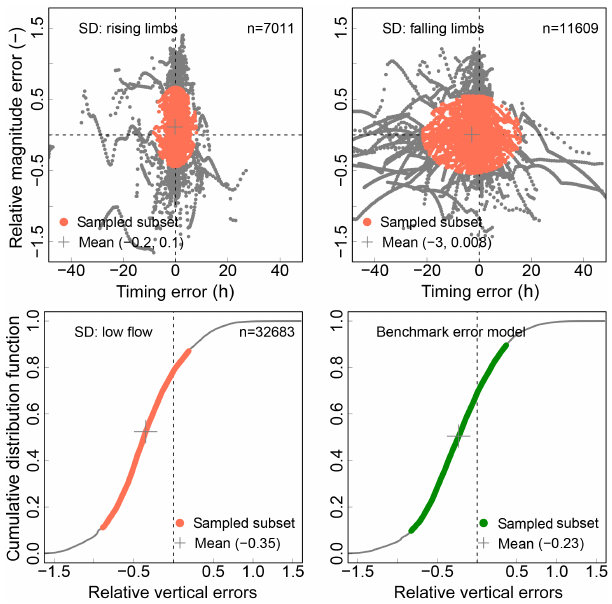
Figure 6. One- and two-dimensional error distributions from the case study. The upper row contains Series Distance (SD) results for the rising and falling limbs. The left panel in the lower row shows the one-dimensional SD distribution of errors for the periods of low flow. The panel in the bottom right contains the 1-D distribution of magnitude errors of the benchmark model (BM) for the entire time series. The highlighted subset represents the 80% subset used to construct the uncertainty envelopes. Distribution statistics are pro- vided in Table 2. To improve the readability of the upper two panels, we restricted their timing axes to the range [ − 45 45]. The number of outliers, i.e. points outside the range mean ± 3SD (standard de- viations) ([ − 42 36]), was < 1% for the falling limbs and 1 order of magnitude less for the rising limbs. The dotted lines highlight the origins (all